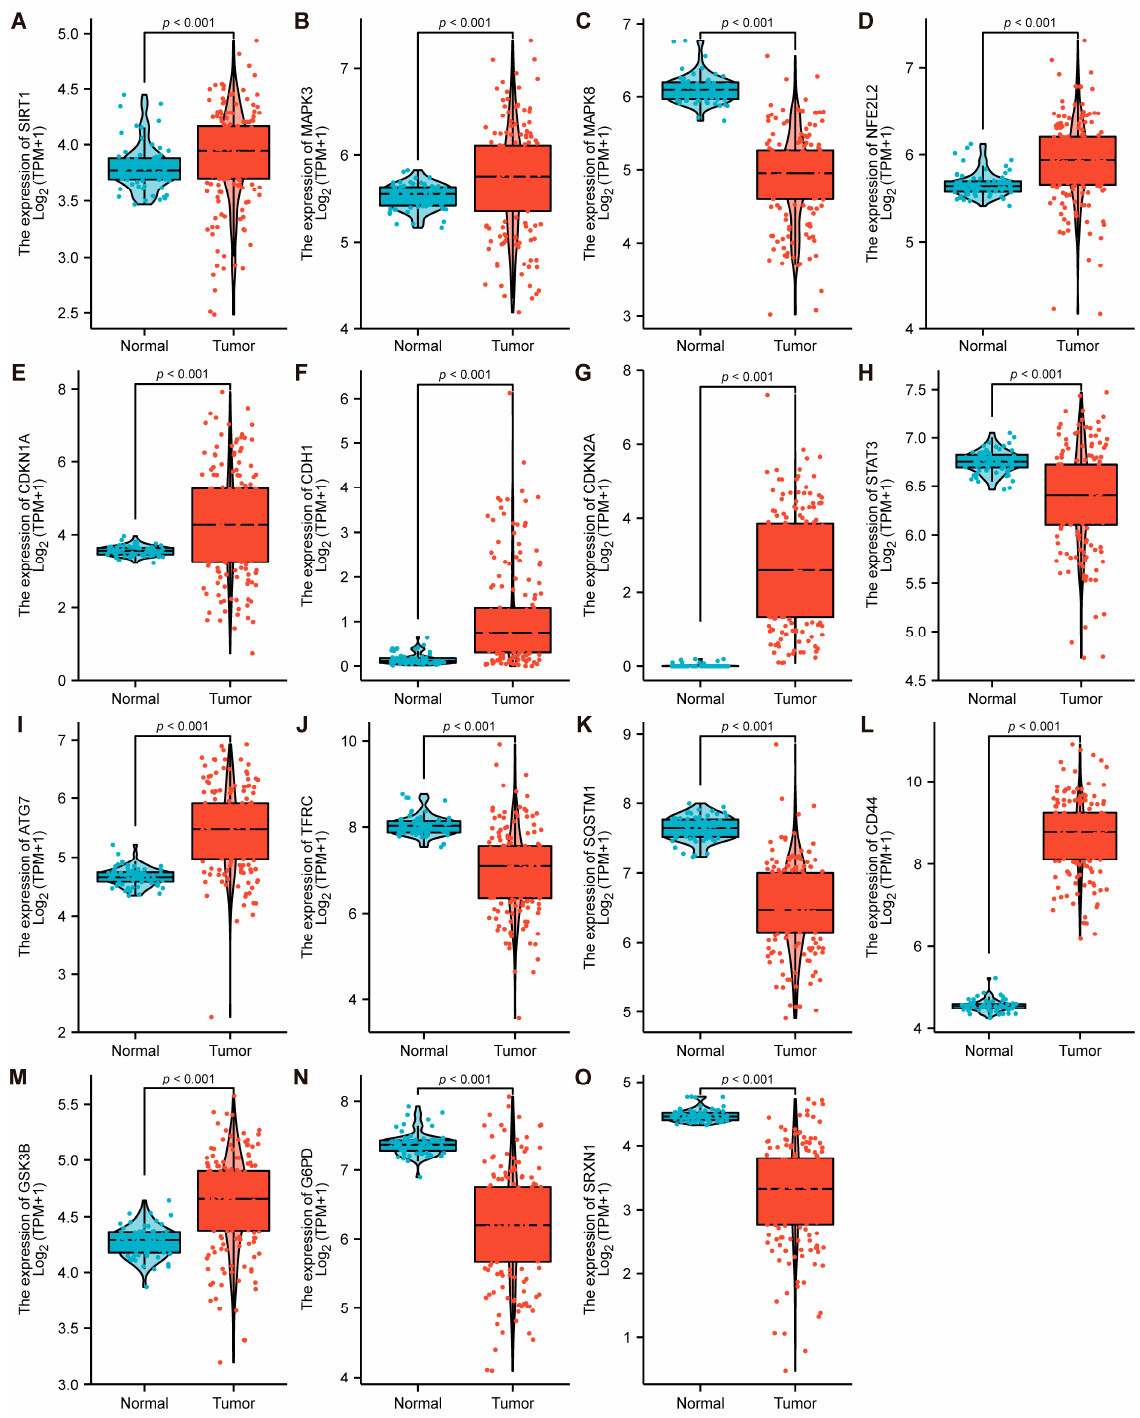
Figure 4. Validation of expression level of 15 Hub genes. ( A – O ) Differential expression analysis of 15 hub genes in AML and normal samples utilizing the TCGA database. The p value was calculated using a Wilcoxon rank sum test.